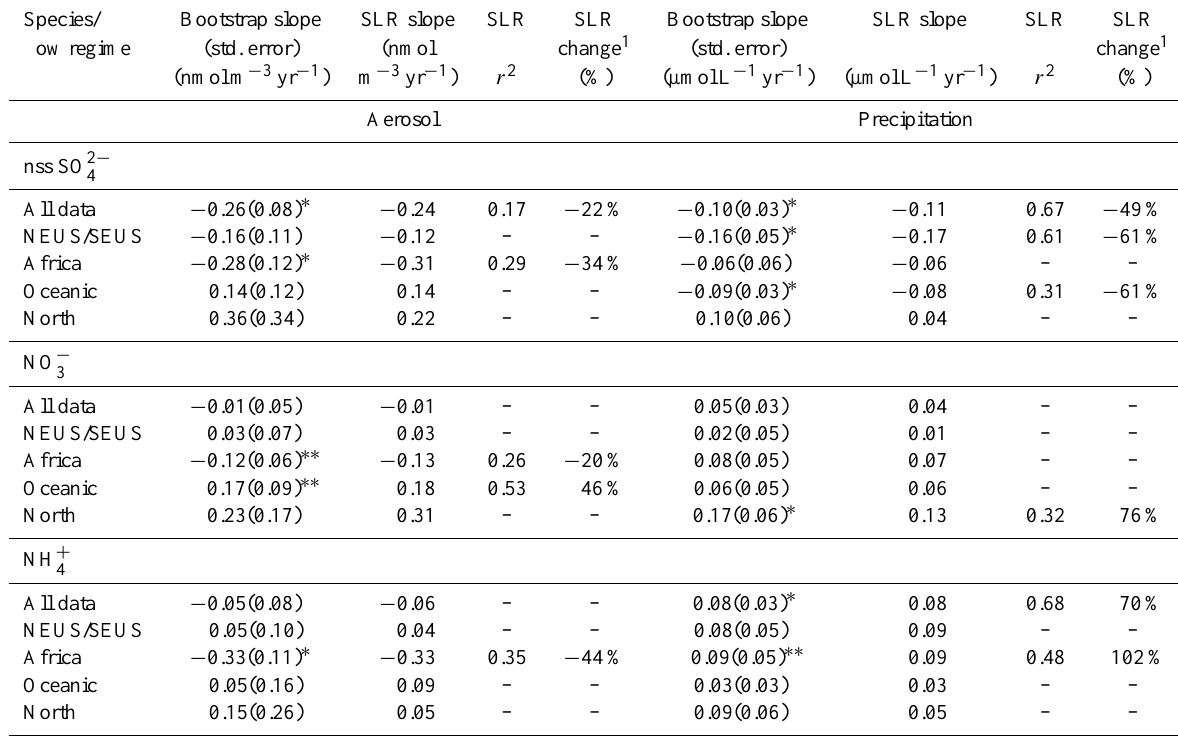
Table 2. Regression statistics and, for significant trends, percent changes in concentrations over the period of record. Species/ Bootstrap slope SLR slope flow regime